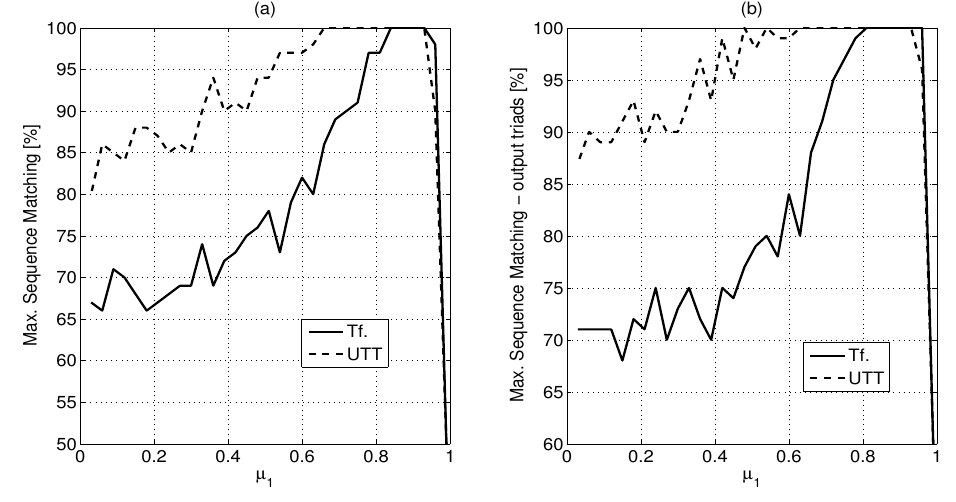
Figure 10. Morning Bell—maximal sequence matching of transformations ( a ) and triads ( b ).